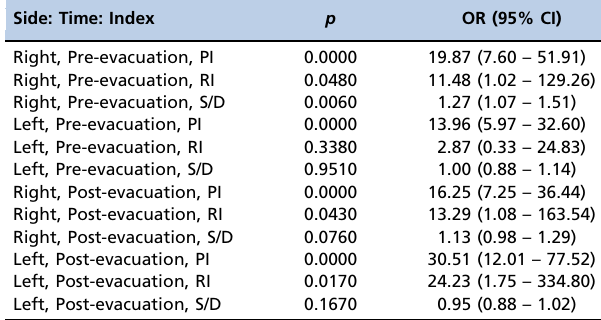
trophoblastic neoplasia following development of a complete hydatidiform mole, adjusted for age, gestational age, size uterus 4 date, theca lutein cysts, and pre-evacuation hCG level.